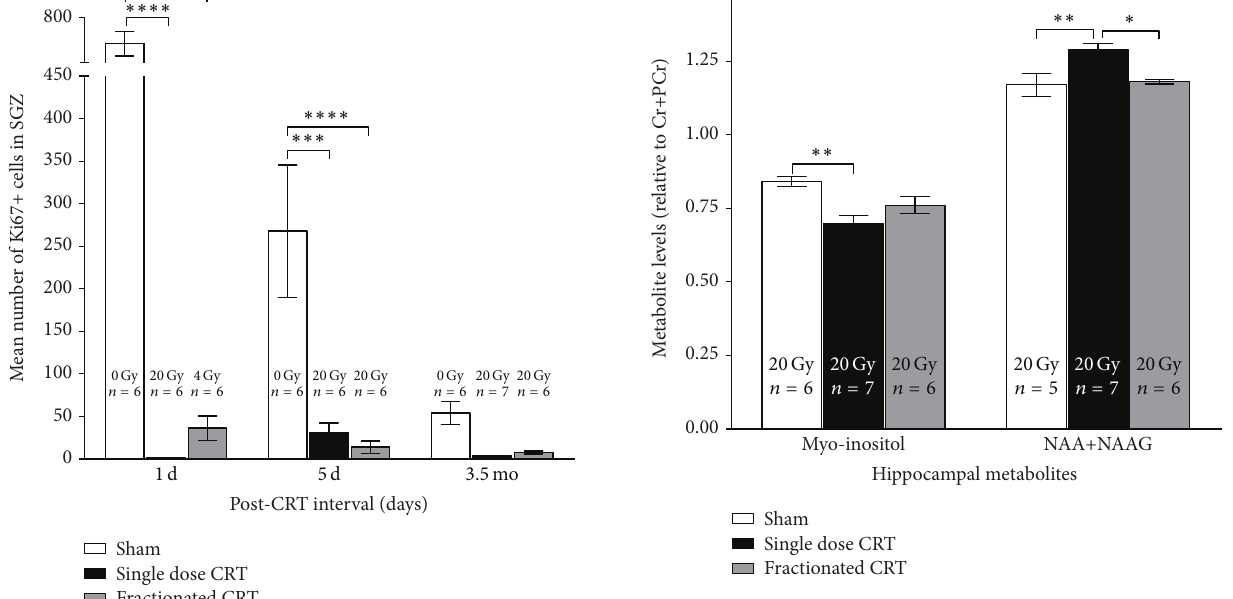
Figure 3: Metabolite changes measured in the hippocampal region at 3 mo after CRT. There was a significant decrease in myo-inositol levels in the single dose group compared to sham, while an increase in NAA + NAAG was measured in the single dose group compared to shams and fractioned CRT [ ∗ 𝑝 < 0.05 , ∗∗ 𝑝 < 0.01